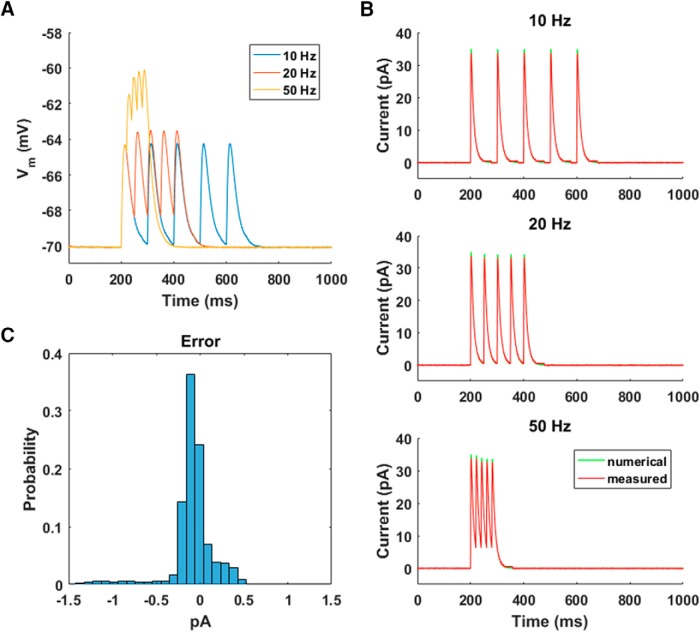
Excitatory postsynaptic currents. A, EPSCs were triggered at fixed times with stimulation frequencies of 10, 20, and 50 Hz. Note how the potentials summate for the higher frequencies. B, The agreement between the currents injected by the dynamic clamp system (measured) and the expected currents given by precise Runge–Kutta numerical integration of the two-stage kinetic scheme we used for EPSCs (Compte et al., 2000) was excellent at all frequencies. C, Histogram of the difference (error) between the measured and expected currents. Data from all three frequencies were combined in this histogram.